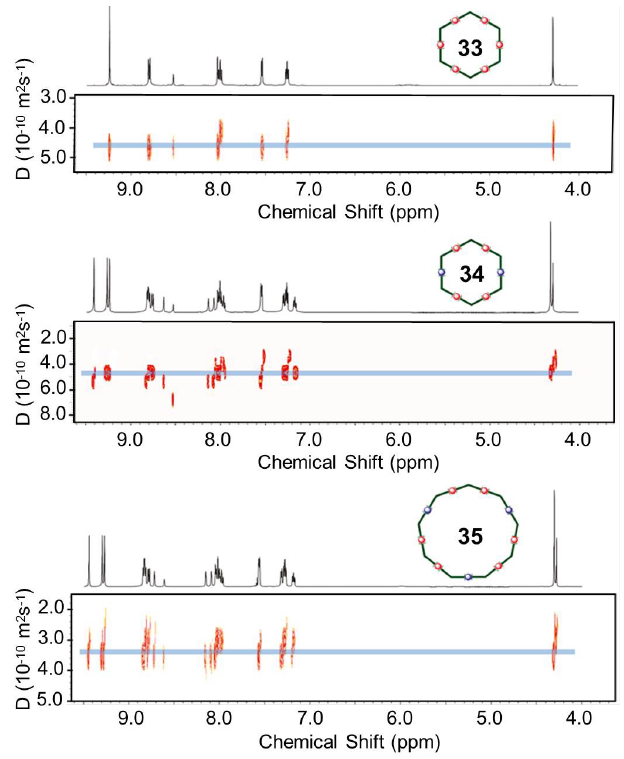
FIGURE 16 – 2D Diffusion Ordered Spectroscopy (DOSY) NMR confirmed ring size [Chan, Y.-T.; Li, X.; Yu, J.; Carri, G. A.; Moorefield, C. N.; Newkome, G. R. J. Am. Chem. Soc. , v.133, p.11967-11976, 2011. – Reproduced by permission of The American Chemical